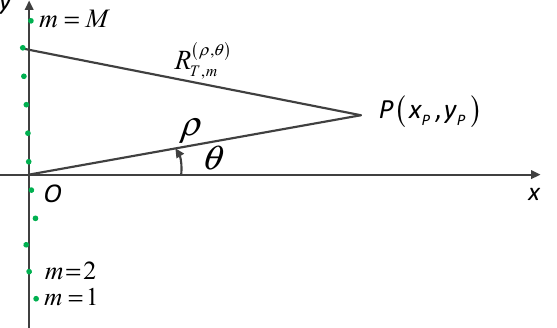
Figure 2. Schematic diagram of a target and an array. The target P is located at in the polar coordinate system. The following condition is satisfied